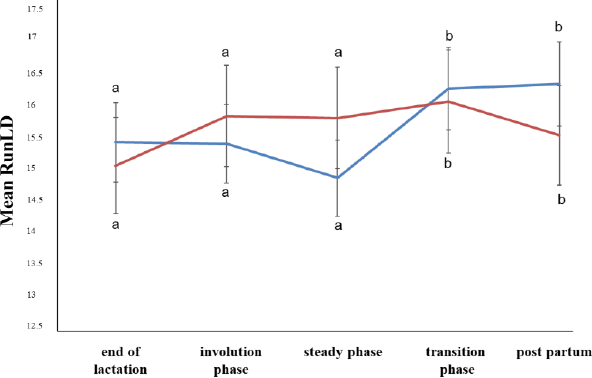
Figure 3. Run length distribution changes among the periods and between the ewe groups ( p ≤ 0.05). The different letter indicators (a, b) represent statistically significant differences between the periods. The blue line represents the ewe group with healthy udders, while the red represents the ewe group with subclinical mastitis.